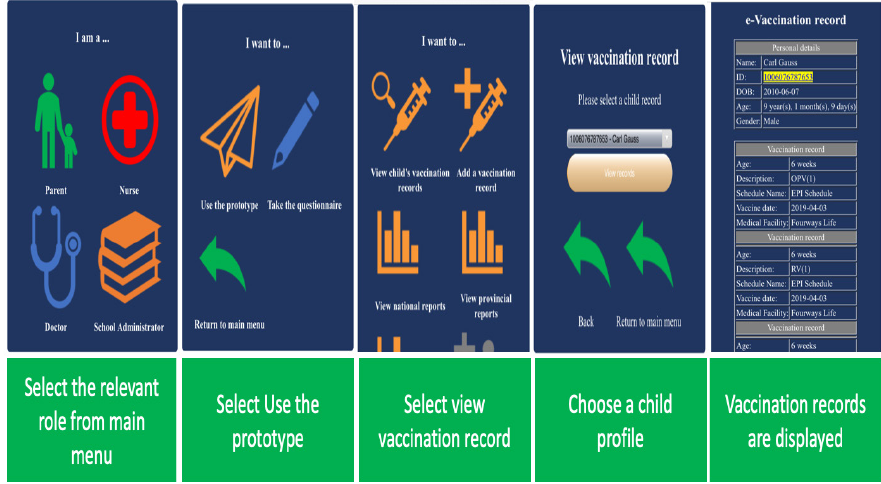
Figure 7: e-Vaccination’s user